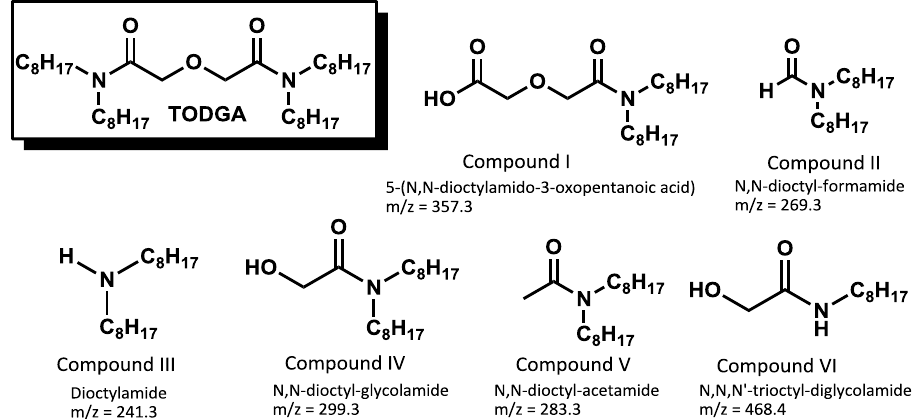
Fig. 4. Structures of TODGA and its main radiolytic degradation